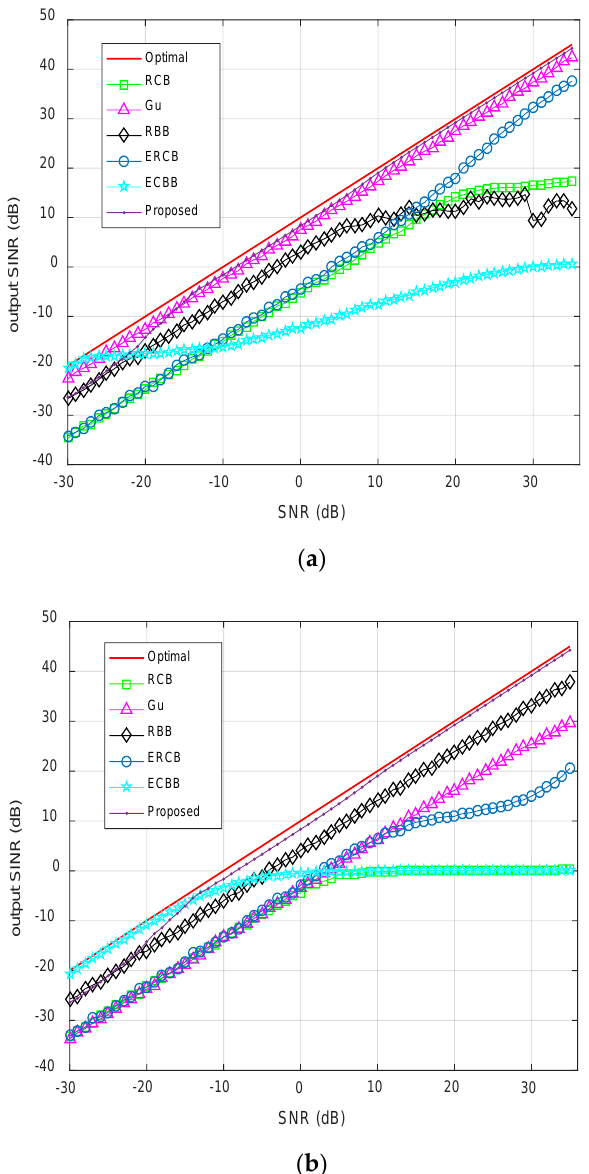
Figure 3. Output SINR against SNR with snapshots fixed at 50: ( a ) Incoherent sources; ( b ) Coherent sources.